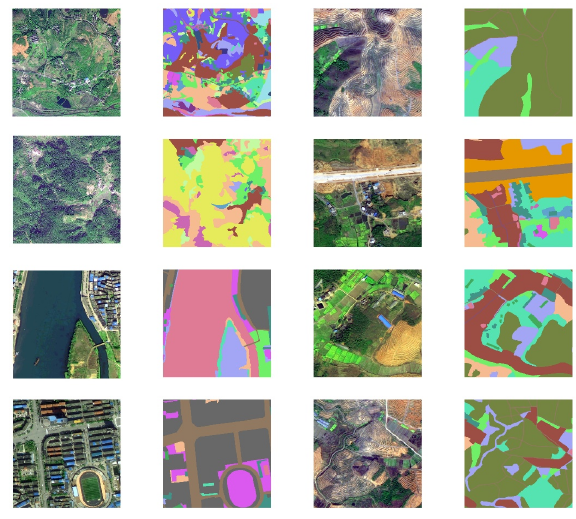
Figure 3. Divided patches and ground